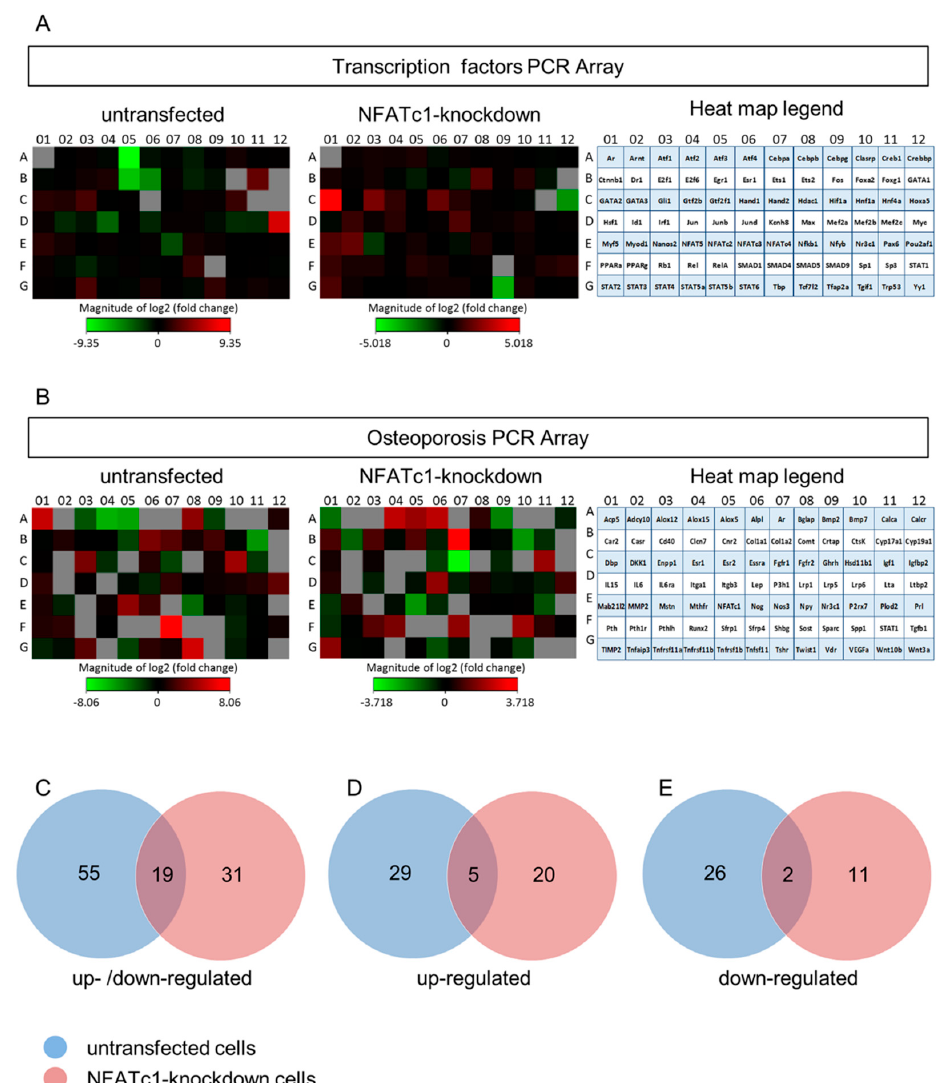
Figure 2. Expression profiles of transcription factors and osteoporosis PCR arrays in untransfected and NFATc1-knockdown RAW 264.7 cells. PCR arrays for transcription factors and osteoporosis were performed. The cluster heat maps for the expression of all genes from ( A ) transcription factors and ( B ) osteoporosis PCR arrays were shown for untransfected cells (left) and NFATc1-knockdown cells (right). The red squares represent up-regulated genes, the green ones down-regulated genes, the black ones unchanged genes and the grey ones are technically unacceptable data. These latter were not considered in the analysis of our results. Differentially expressed genes between untransfected and NFATc1-knockdown cells, RANKL-induced. ( C ) Up- and down-regulated genes, ( D ) up-regulated genes, ( E ) down-regulated genes.